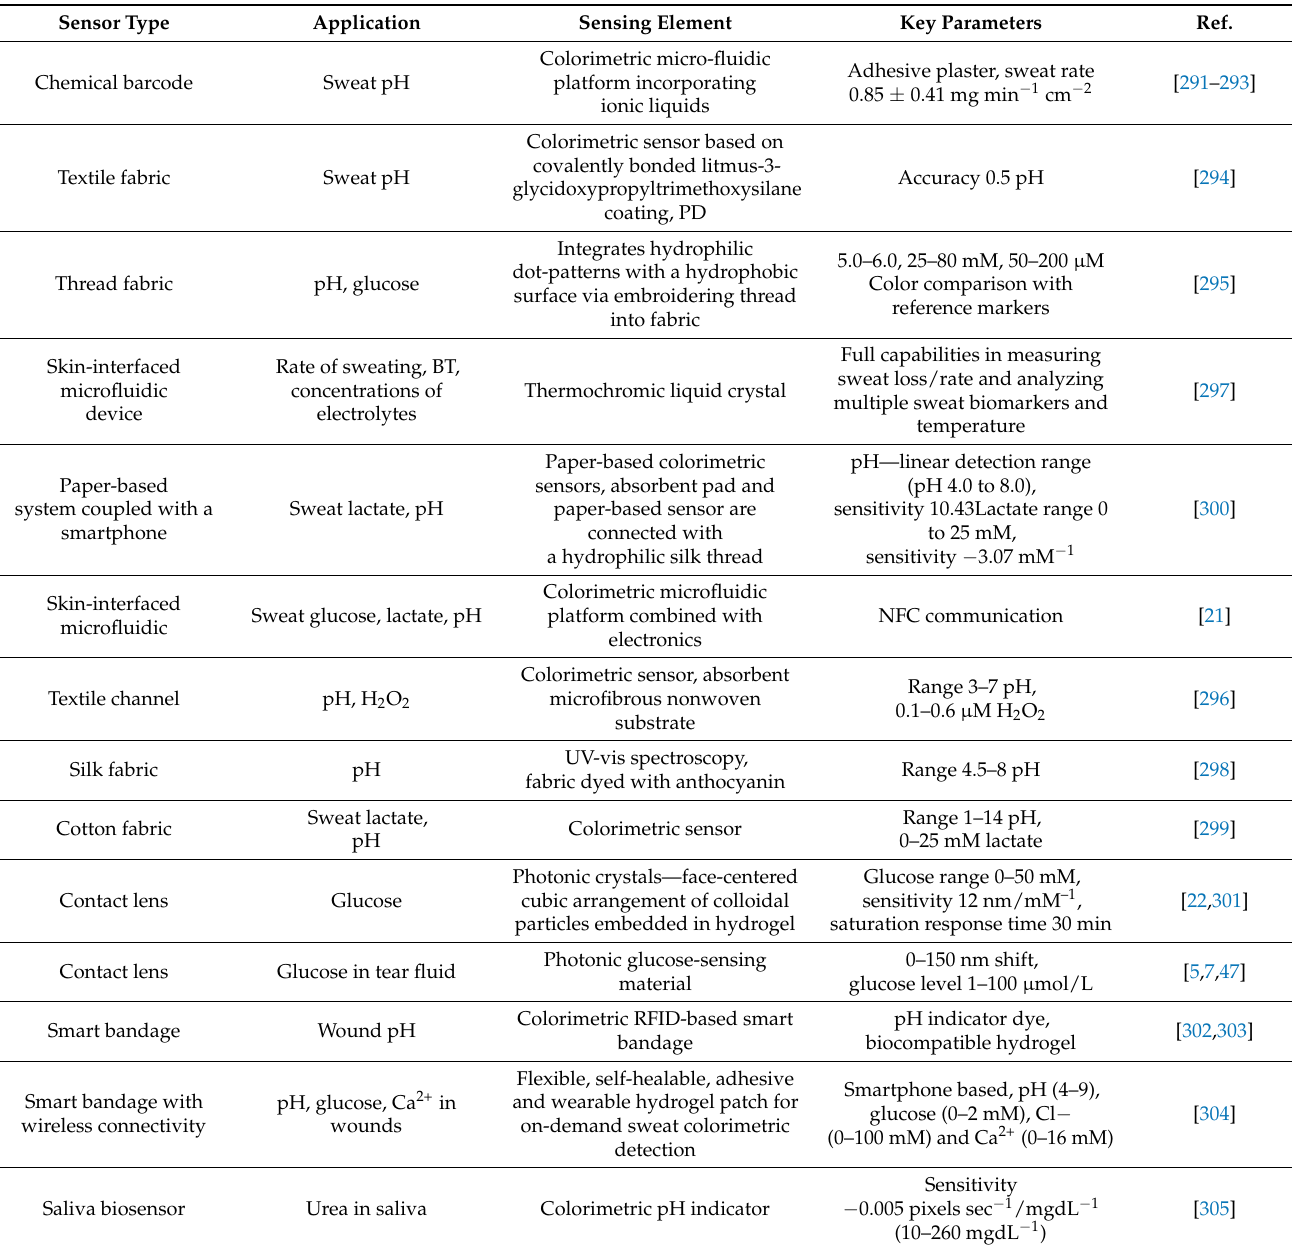
Table 4. Biochemical